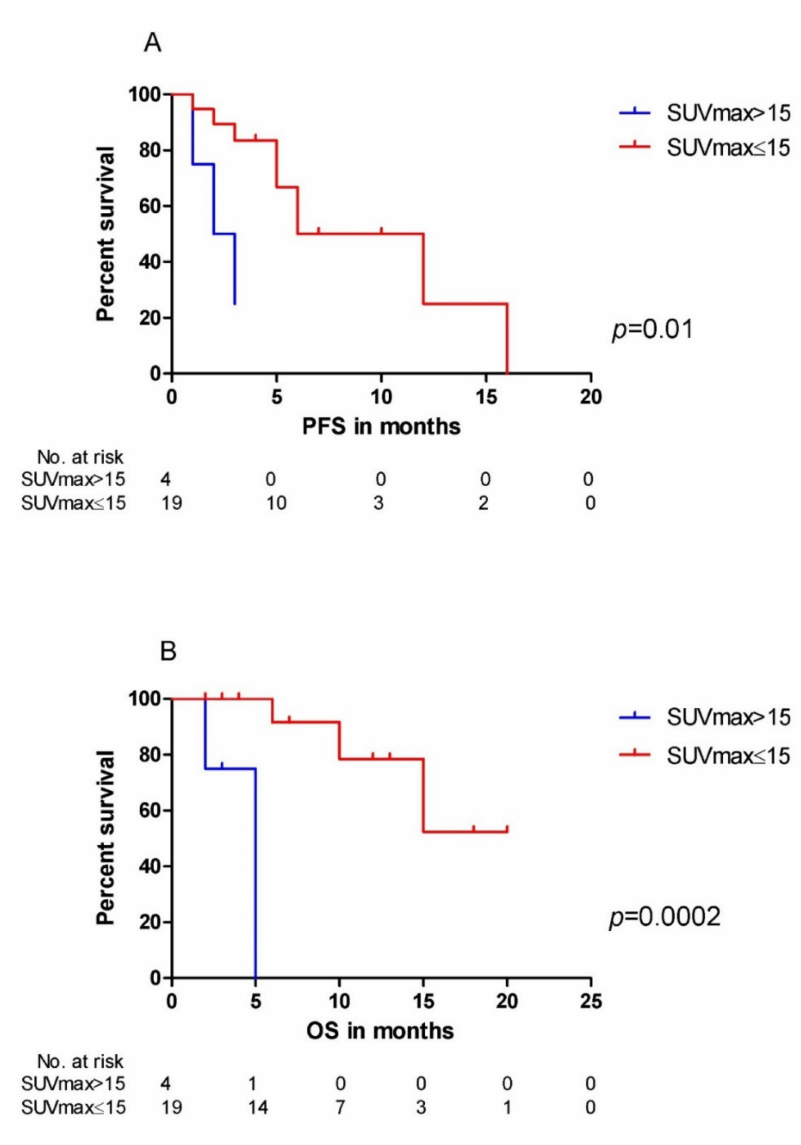
Figure 3. Maximum standardized uptake value (SUV max ) and survival: ( A ) Progression free survival (PFS) of patients with SUV max > 15 ( n = 4) was significantly shorter than that in patients with SUV max > 15 ( n = 4) had a significantly inferior overall survival ≤ 15 ( n = 19) ( p = 0.01). ( B ) Patients with SUV max (OS) compared to those with SUV max ≤ 15 ( n = 19) ( p =